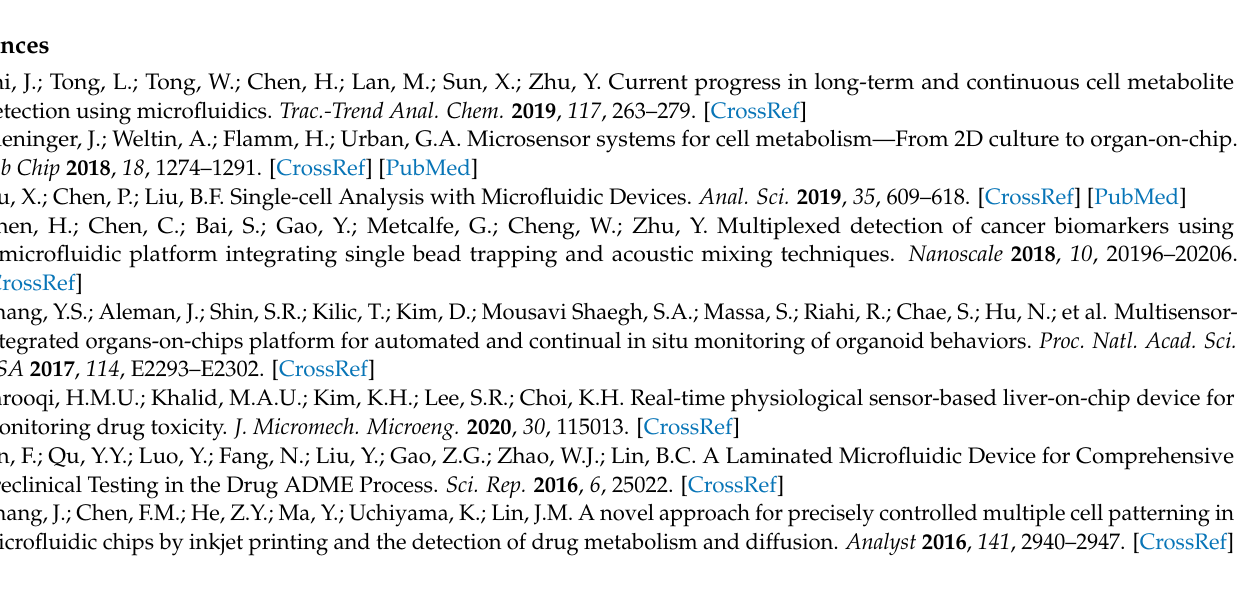
Figure S2. The influence of particle number on simulation results. The particle number from A to E is 2600, 22k, 90k, 250k and 560k respectively; Figure S3. The influence of grid number on simulation results. The grid number from A to E is 0.3 million, 0.8 million, 3.7 million, 4.6 million and 9.6 million